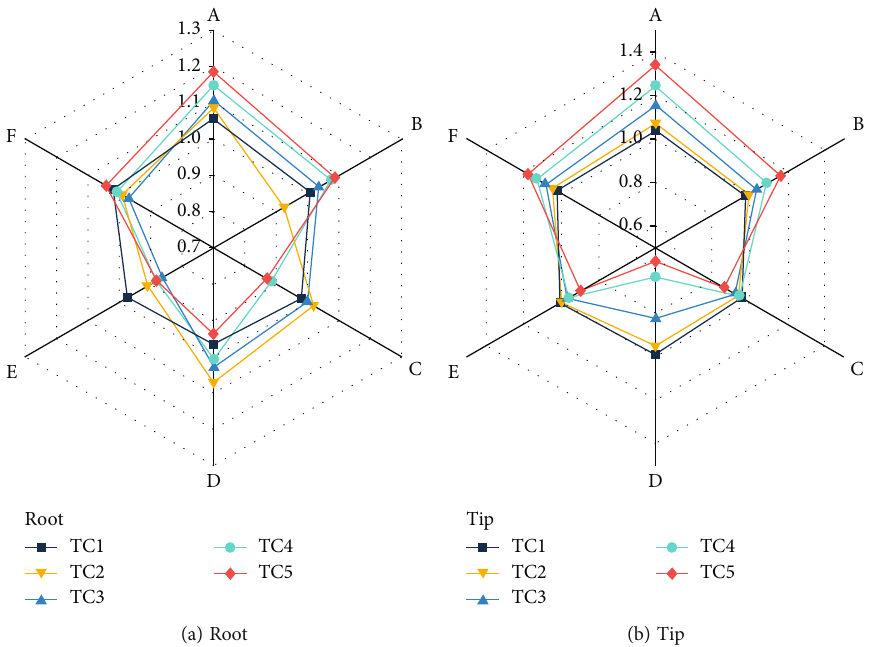
Figure 9: Normalized static pressure distribution at the L-0 outlet.